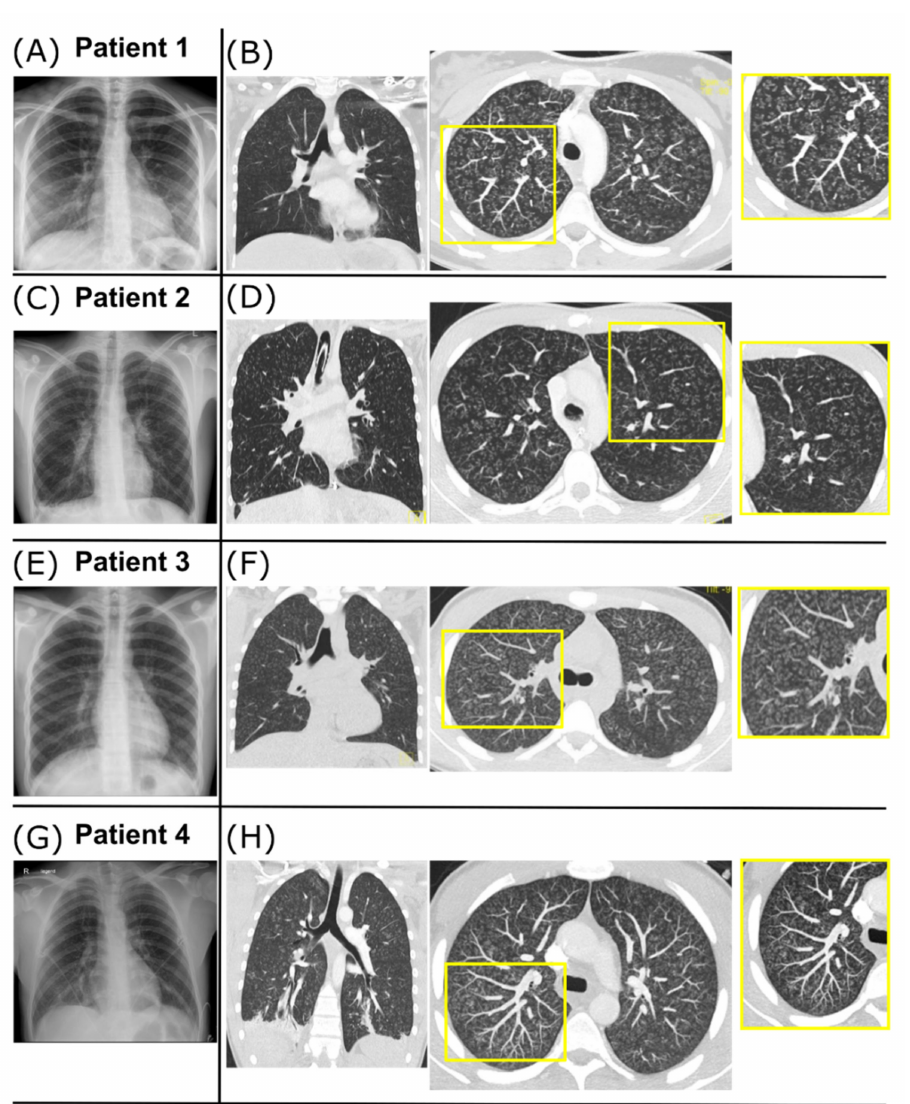
Figure 2. Radiographic findings. ( A , B ) Radiographic findings for Patient 1. Chest X-ray on day 2 showing signs of peribronchial cuffing ( A ). Coronal CT image on day 8 shows diffuse and ho- mogenous distribution of centrilobular micronodules and tree-in-bud pattern through the whole lung ( B , left). Axial maximal intensity projection (MIP, 5 mm thickness) of the CT scan improves the detection and distribution of the disease pattern ( B , right). In the magnified view, the tree-in-bud pattern is mostly explained by peribronchial thickening. ( C , D ) Radiographic findings for Patient 2. Chest X-ray on day 1 shows slight enlargement of the hilar lymph nodes, increased peribronchial and interstitial markings, small opacification in the right basal area, and small bilateral pleural effusions ( F ). Coronal CT image on day 4 ( G , left) and axial MIP magnification ( G , right) show diffuse and homogenous tree-in-bud pattern, mostly due to endobronchial pathology ( G ). ( E , F ) Radiographic findings for Patient 3. Chest X-ray on day 6 shows diffuse bilateral peribronchial markings with basal dominance and small pleural effusions suspicious for atypical pneumonia ( E) . Coronal CT image on day 6 ( F , left) and axial MIP magnification ( F , right) show tree-in-bud pattern due to peribronchial thickening with diffuse and homogenous distribution through the whole lung. ( G , H ) Radiographic findings for Patient 4 (provided by the Department of Radiology, Medical University Innsbruck, Austria). Chest X-ray on day 1 shows bilateral widespread nodular opacities ( G ). Coronal CT image on day 2 ( H , left) and axial MIP magnification ( H , right) show diffuse and homogenous tree-in-bud pattern through the whole lung caused by peribronchial thickening ( H